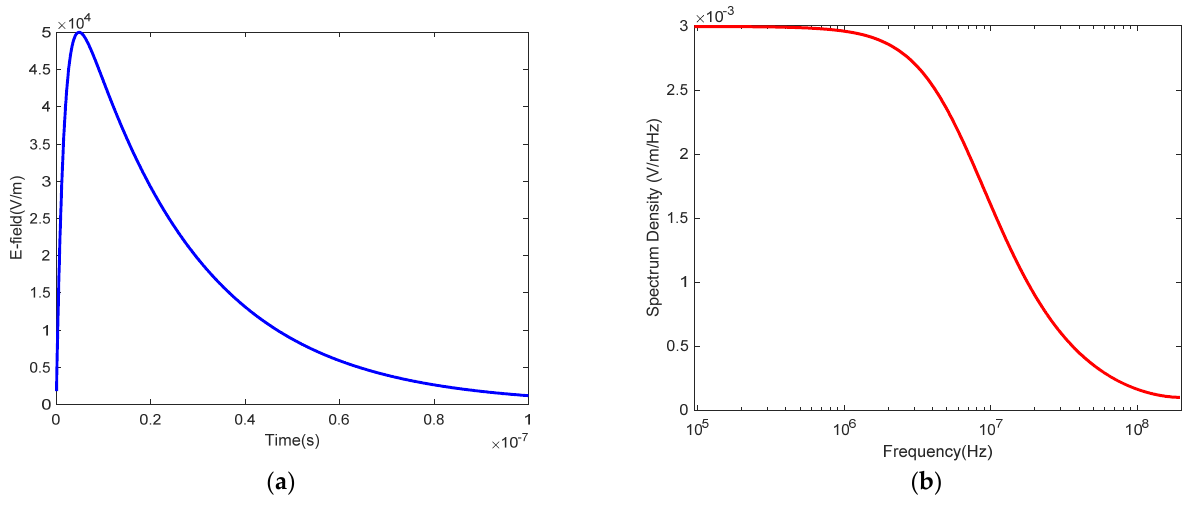
Figure 3. HEMP waves: ( a ) time domain; ( b ) frequency domain.